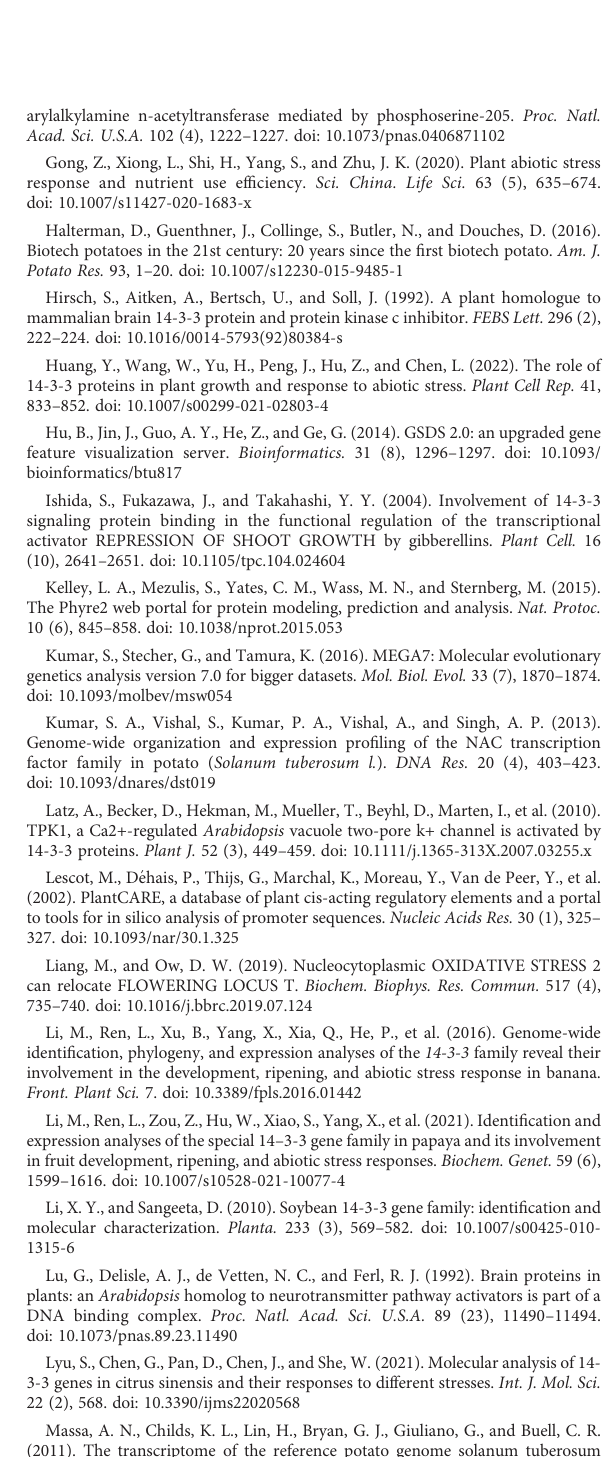
SUPPLEMENTARY TABLE 3 List of gene-speci fi c primers used in the present study.